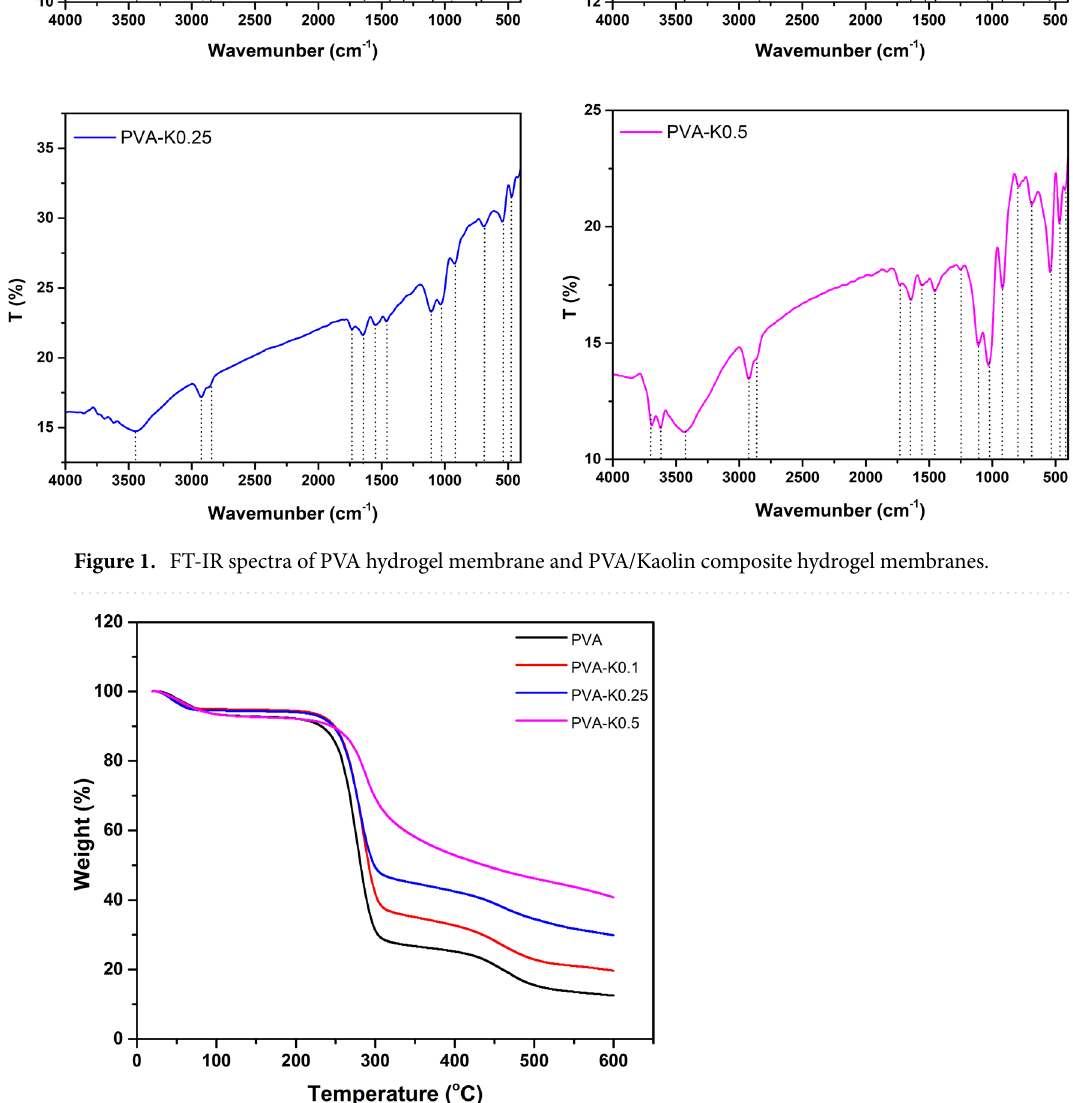
Figure 2. TGA curves of PVA hydrogel membrane and PVA/Kaolin composite hydrogel